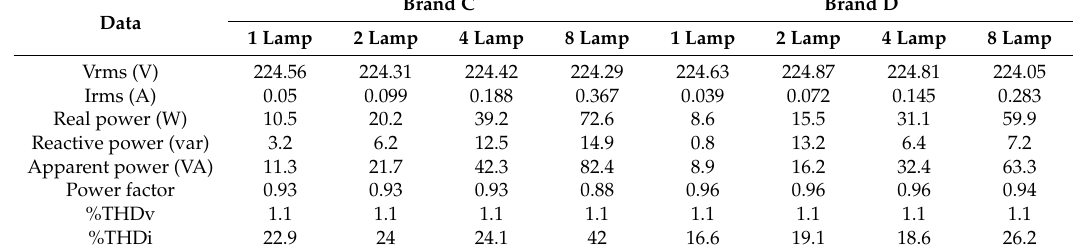
Table 4. Summary results from experimental setup for LED light bulb type.